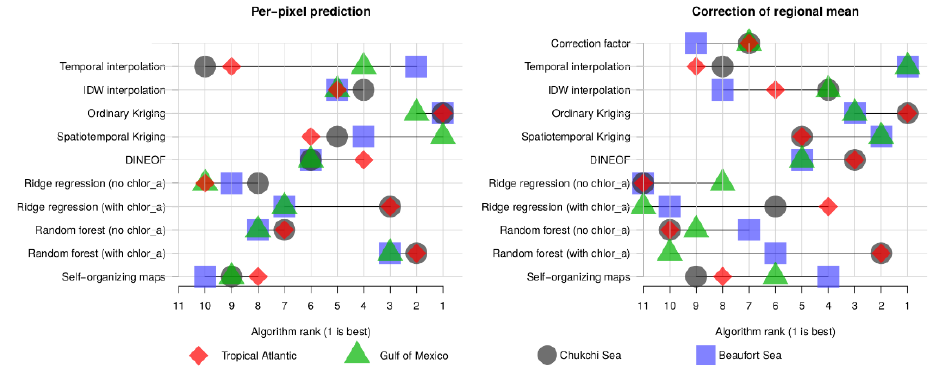
Figure 7. Algorithms ranked by RMSE (1 means lowest RMSE) for the two gap-filling tasks in the four study areas. Note that in many cases, algorithms with neighboring ranks had very similar errors. The exact RMSEs are shown in Figures 5 and 6.